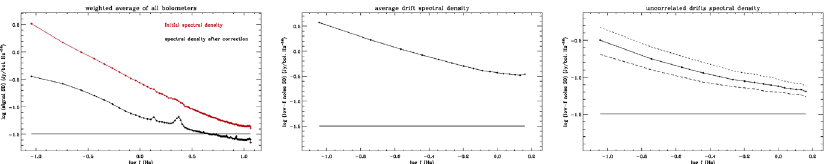
Figure 5. Spectral densities of: (a) the average signal, before and after the processing ; (b) the average drift ; (c) the individual